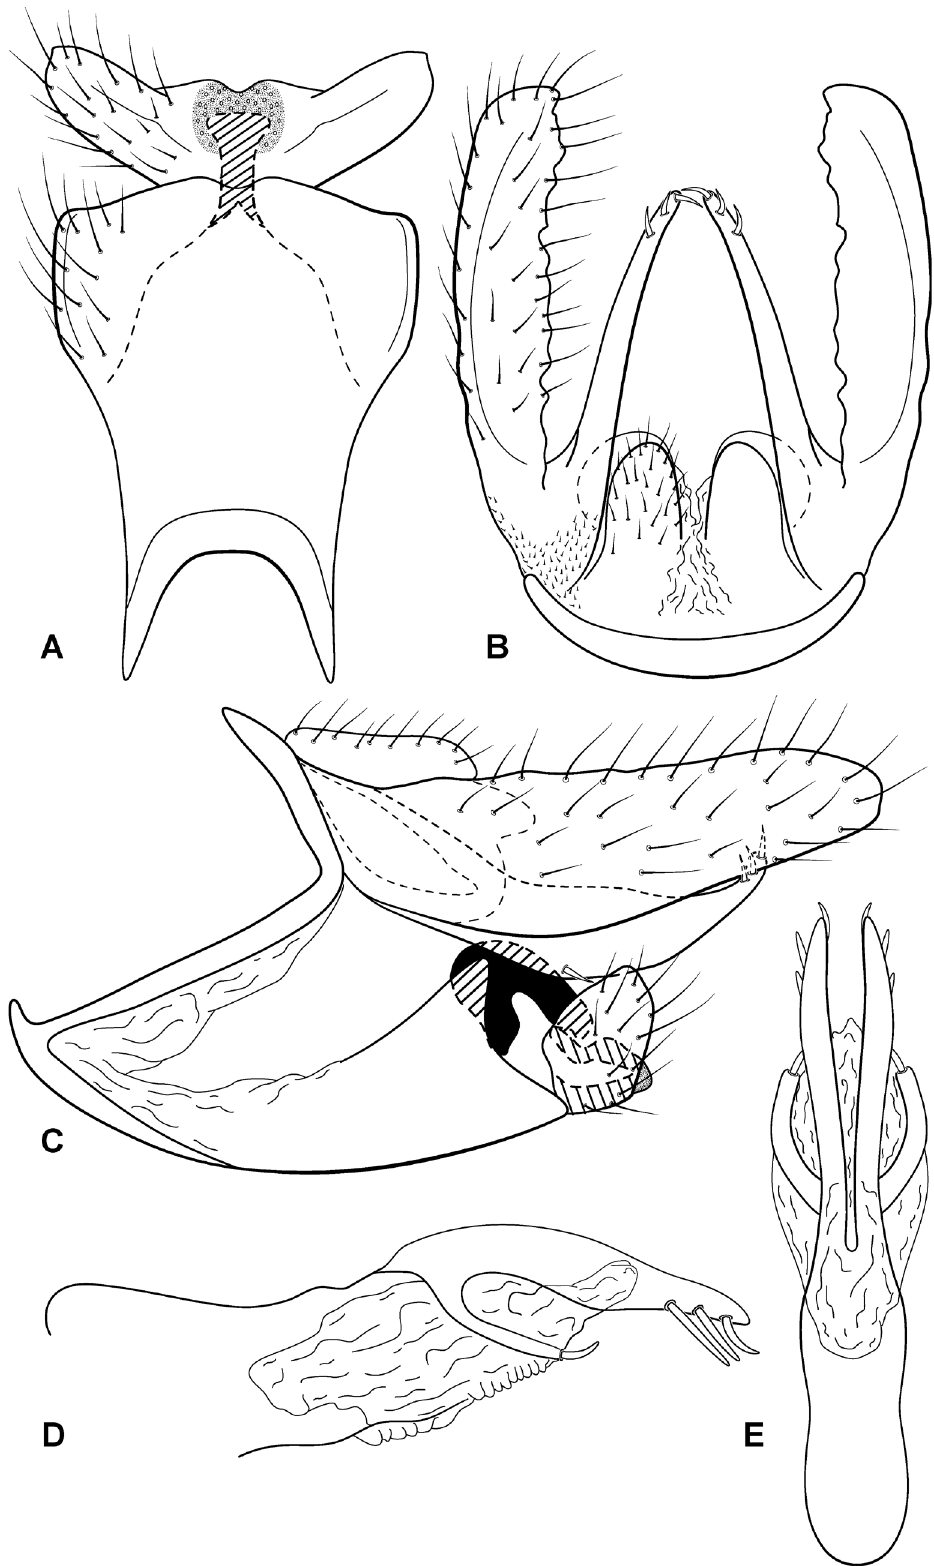
Fig. 7. Austrotinodes donagrazielae sp. nov., male genitalia. A . Ventral view. B . Dorsal view. C . Left lateral view. D . Phallic apparatus, left lateral view. E . Phallic apparatus, dorsal